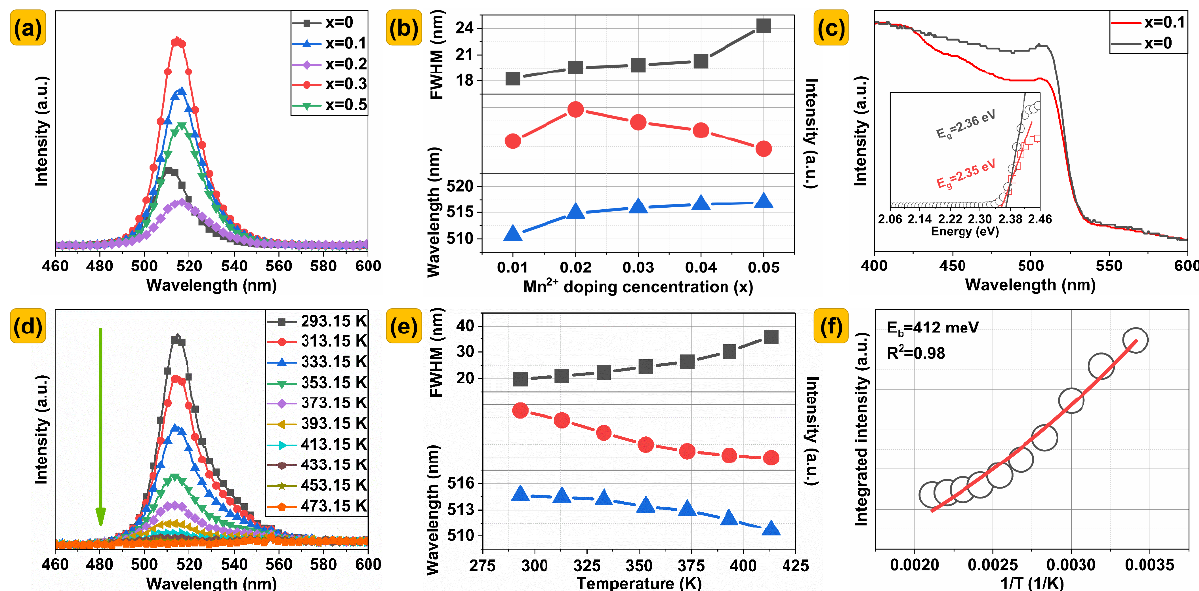
Figure 3. ( a ) PL spectra. ( d ) Temperature−dependent PL spectra of Cs (Pb 0.9 Mn 0.1 )Br 3 PQDS@glasses. The detailed FWHM, emission intensities , and peak positions of ( b ) PL and ( e ) temperature−dependent PL spectra of the PQDS@glasses. ( c ) Absorption spectra of PQDS@glasses. (x = 0, 0.1) ( f ) Integrated PL emission intensity as a function of 1/T.